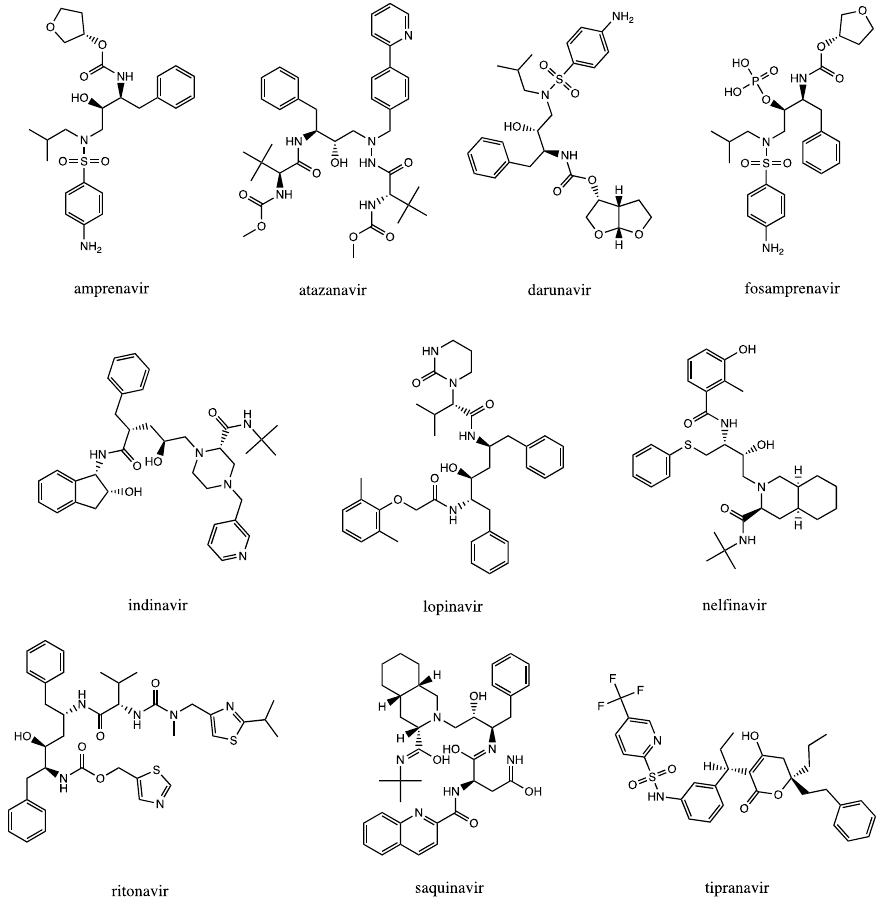
Figure 1. Chemical structures of the HIV-1 PR inhibitors approved by the FDA since 1995. All FDA-approved HIV-1 PRIs (saquinavir and amprenavir are no longer marketed; ri- tonavir, fosamprenavir, lopinavir, indinavir, atazanavir, nelfinavir, tipranavir and